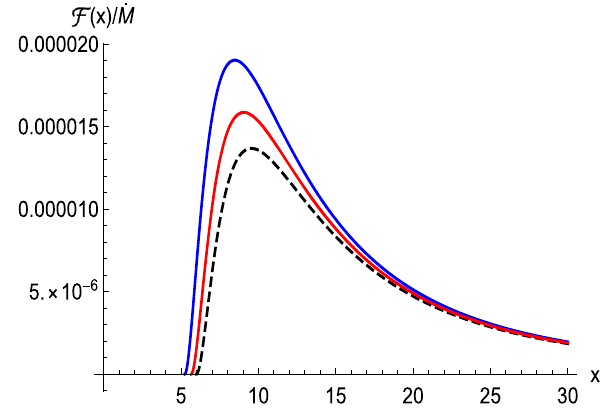
Fig. 6 Energy flux per unit accretion rate from a thin accretion disk around a RGI-Schwarzschild black hole for ˜ ξ = ˜ ξ c = 16 / 27 (blue) and ˜ ξ = 0 . 3 (red). The black dashed curve is the energy flux from the disk around a classical Schwarzschild black hole ( ˜ ξ = 0)